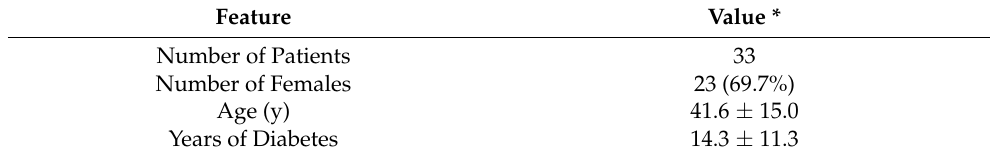
Table 1. Demographic characteristics of the patients of the study. * N (%) or mean ± standard deviation.